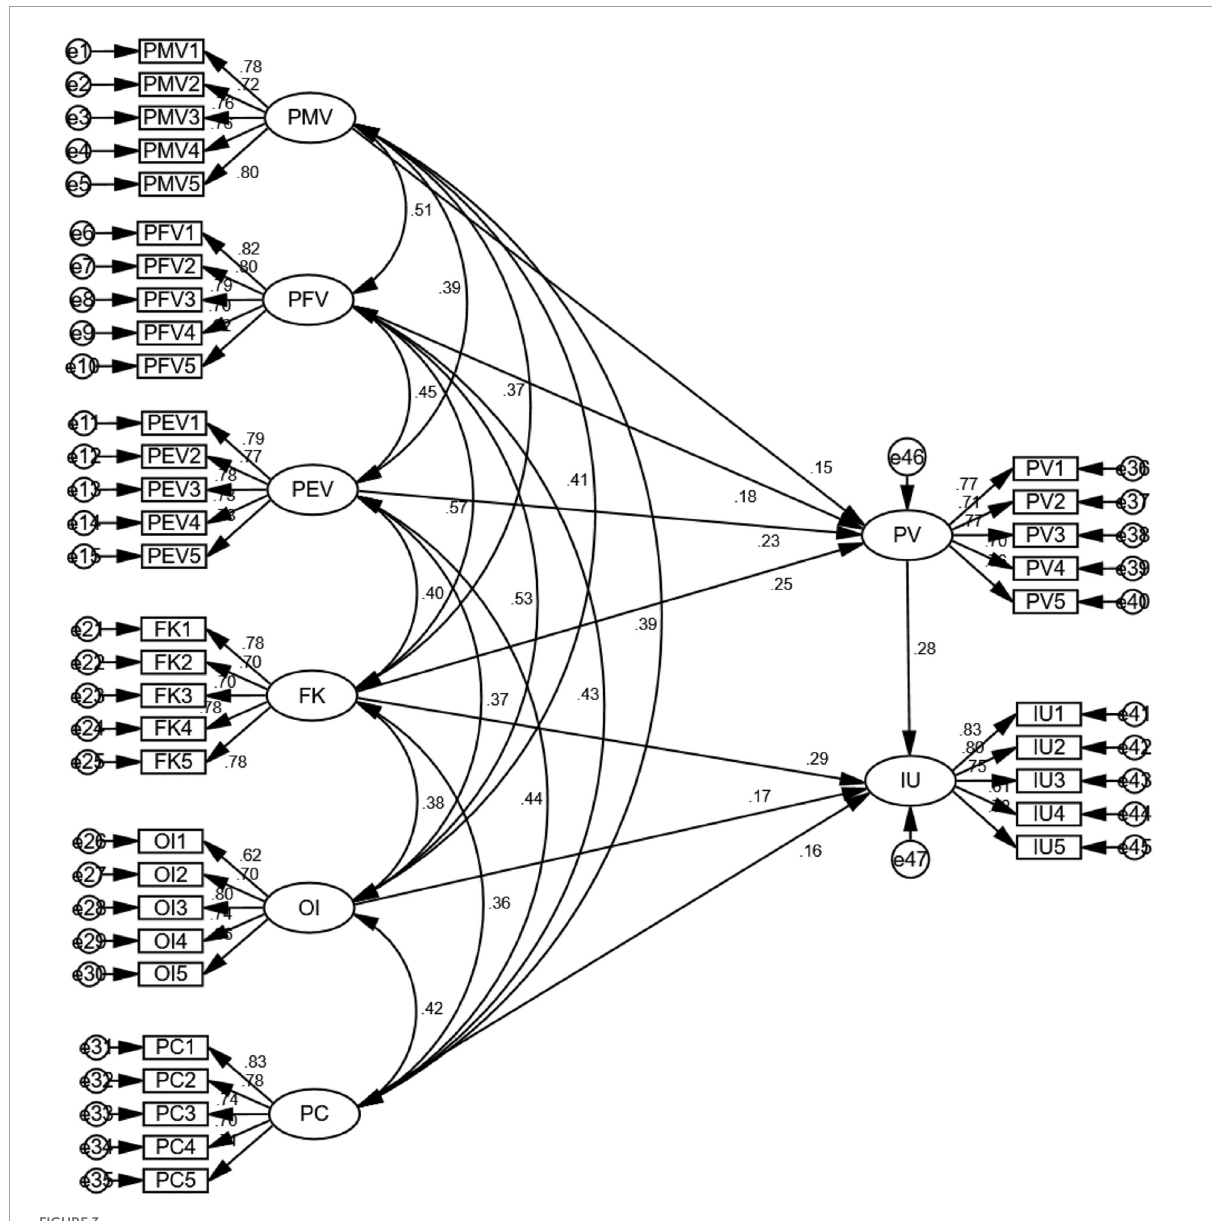
FIGURE3 Diagram illustrating the structural model.